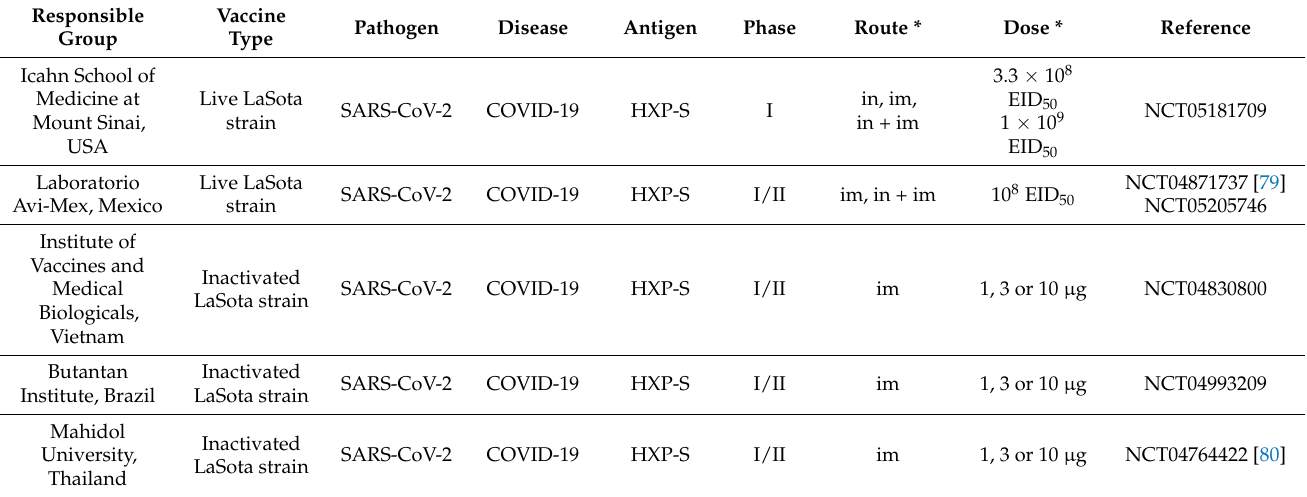
Table 2. Recombinant NDV-vectored vaccine candidate in clinical trials for human